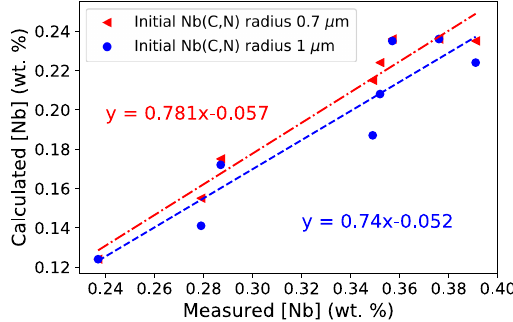
Figure 11. Comparison of mean Nb contents in austenite for different heat treatments: experimental EPMA measurements and predictions from the reduced model based on results obtained by DICTRA (nine-element simulation using TCFE9) for two initial radii of